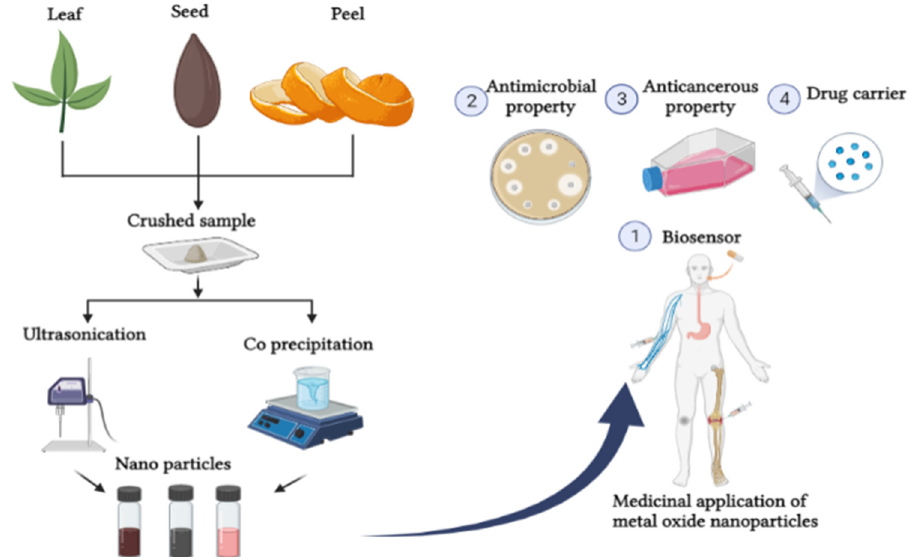
Figure 5. Medicinal applications of green synthesized metal oxides (created on 14 April 2022 by BioRender.com).